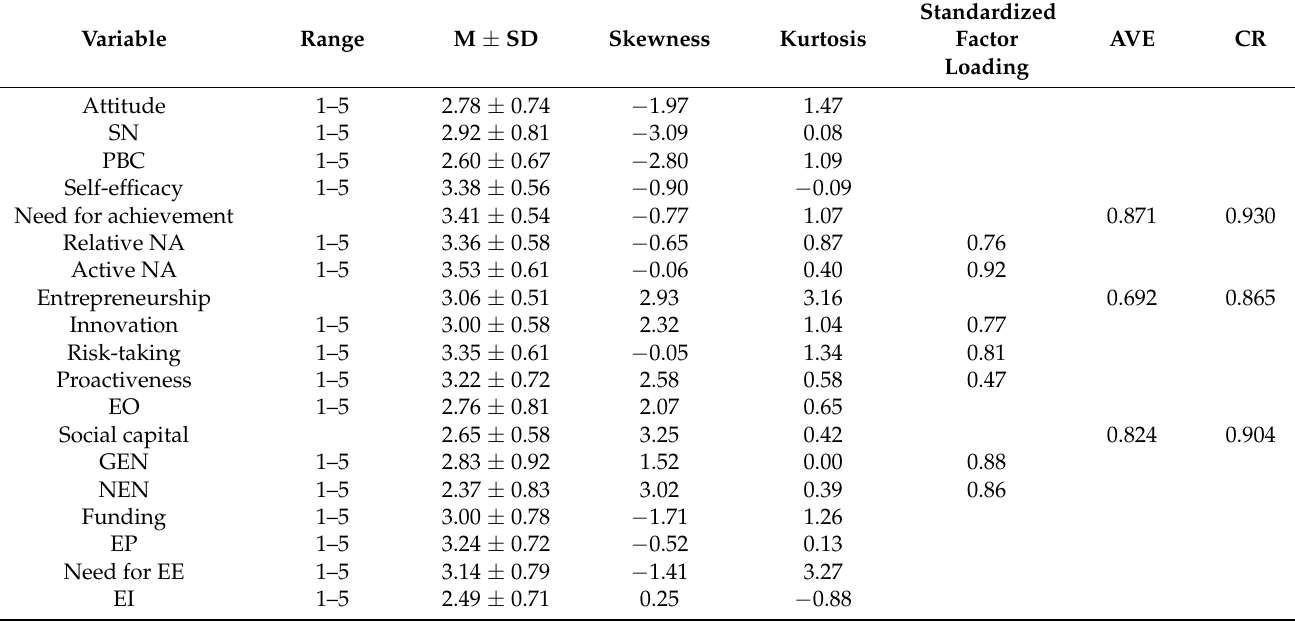
Table 3. Descriptive statistics and confirmatory factor analysis of measurement